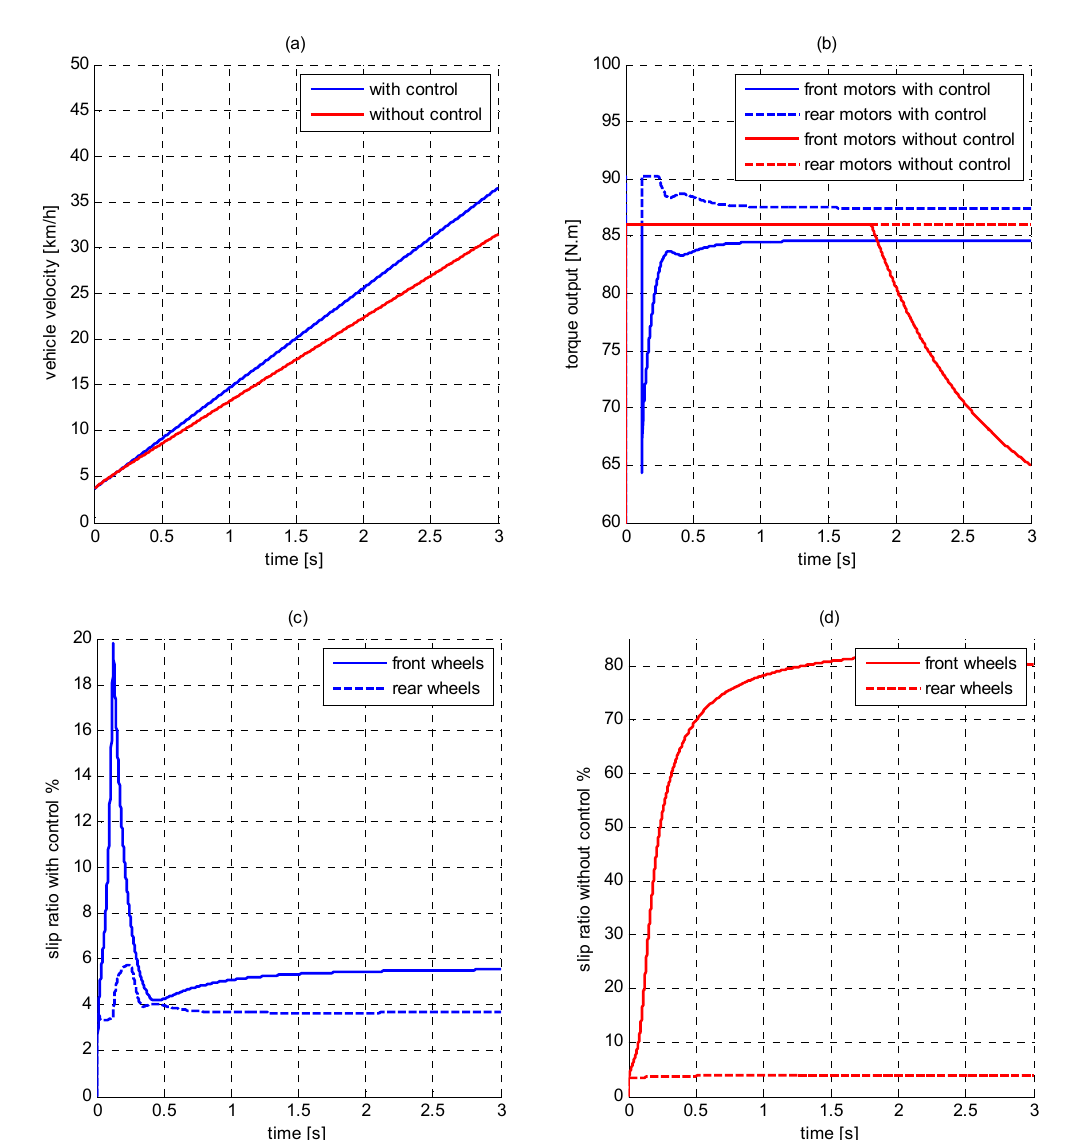
Figure 10. Simulation results of the vehicle with and without inter-axles traction allocation: ( a ) vehicle velocity; ( b ) motor torque output; ( c ) wheel slip ratio with inter-axles traction allocation; and ( d ) wheel slip ratio without control.